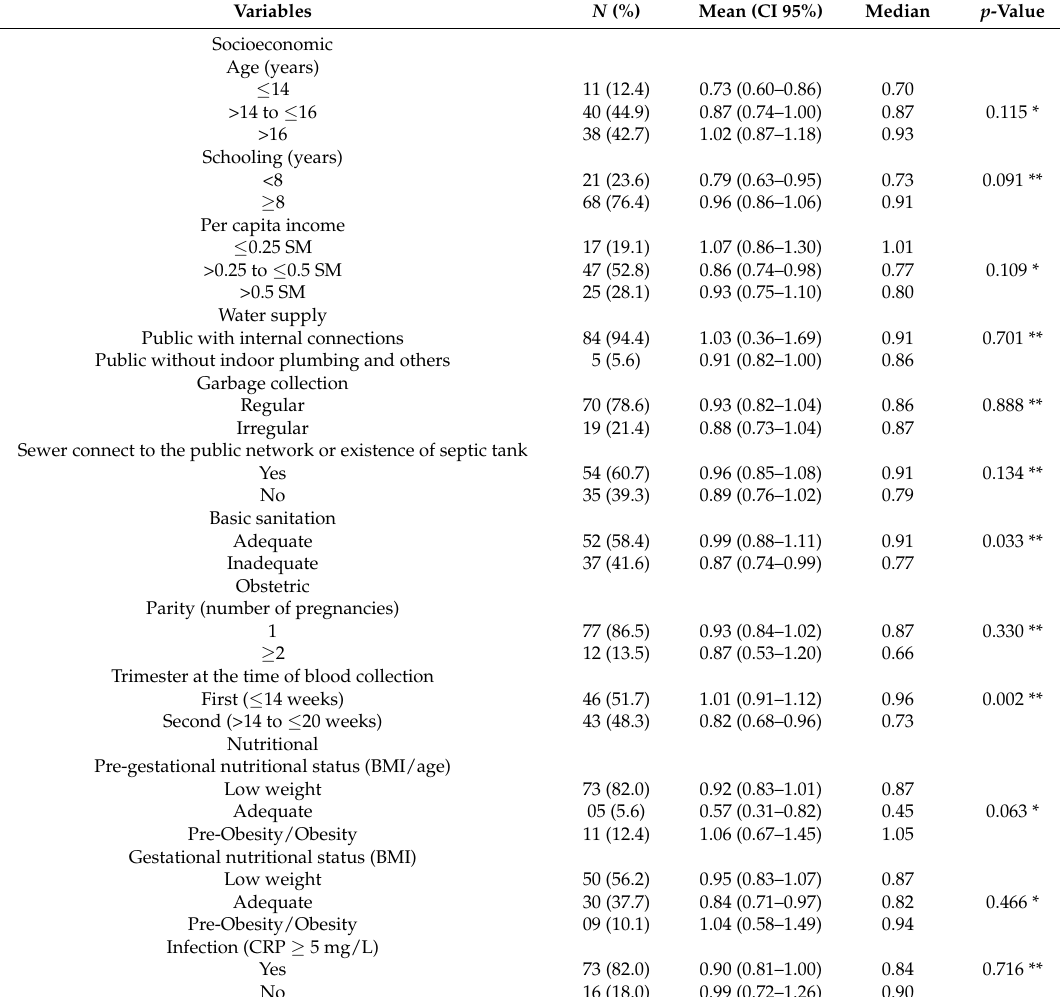
Table 1. Serum retinol levels of the participants according to socioeconomic, obstetric, nutritional, and the presence of infection (CRP)